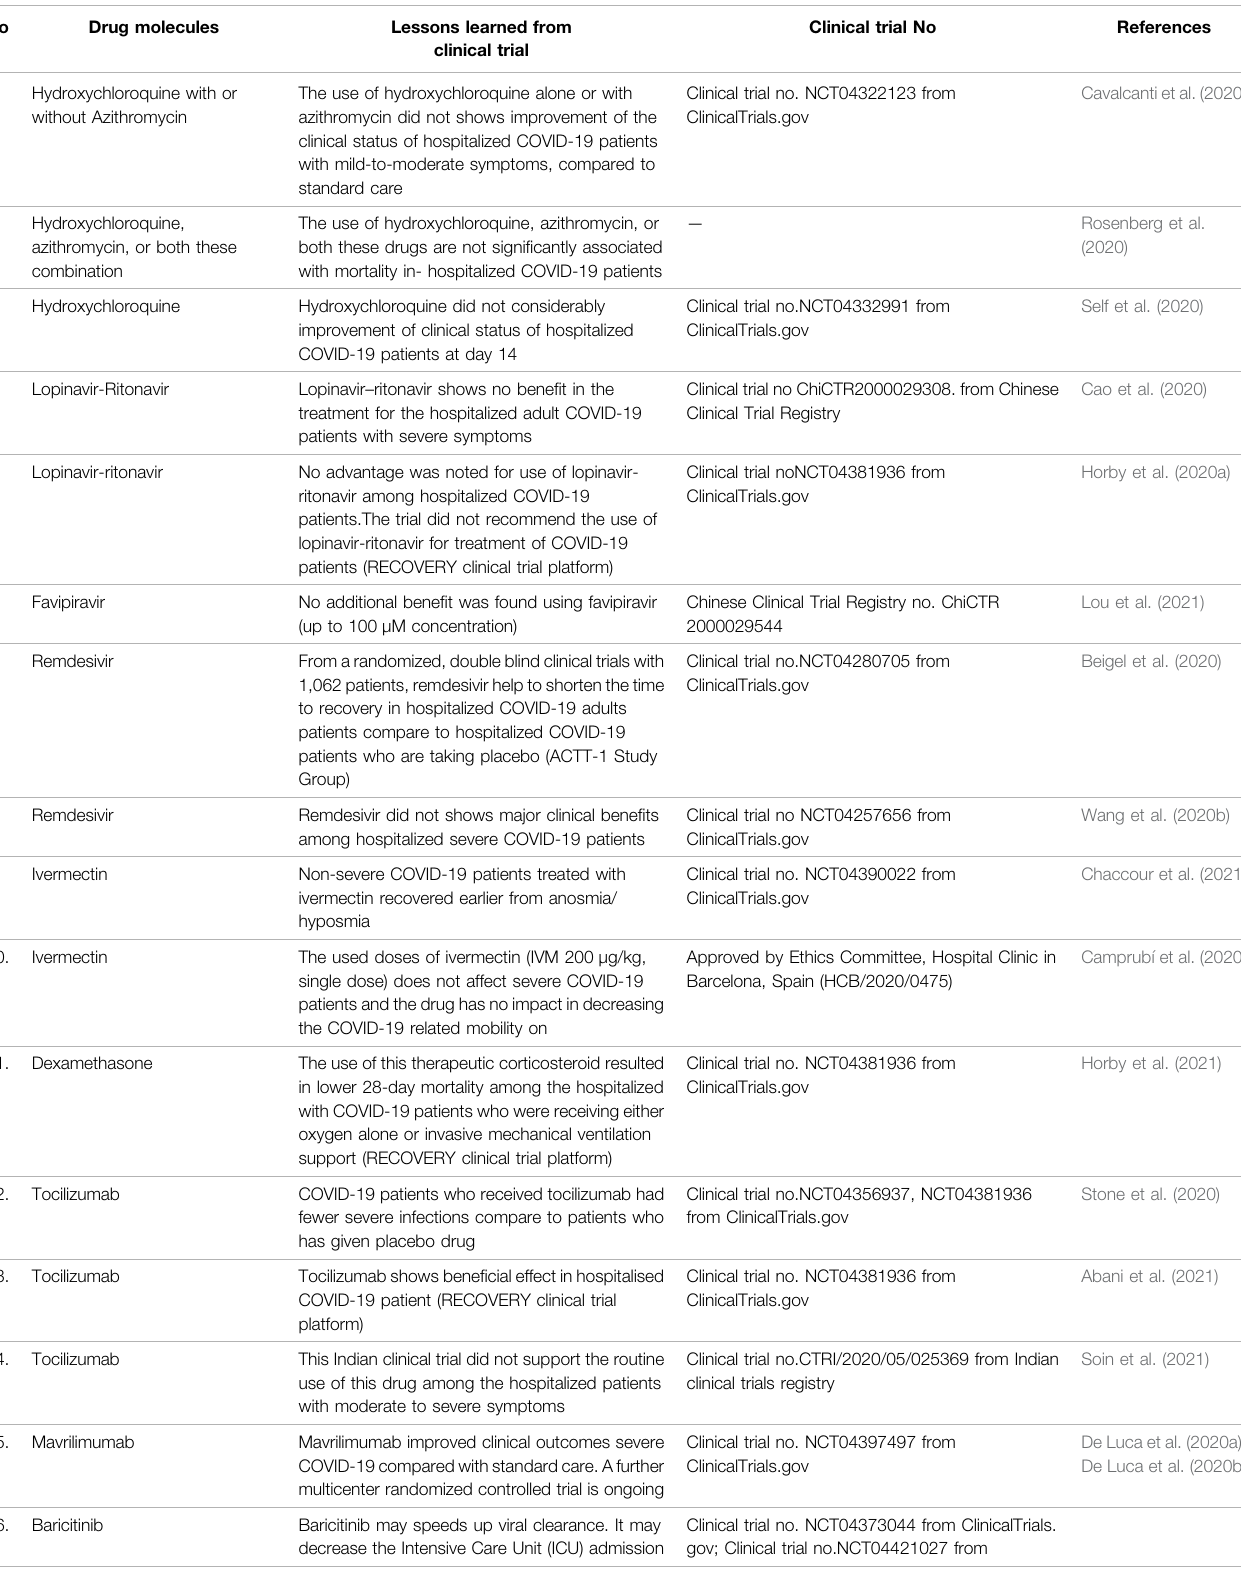
TABLE 2 | Lessons learned from a clinical trial for therapeutic repurposing against